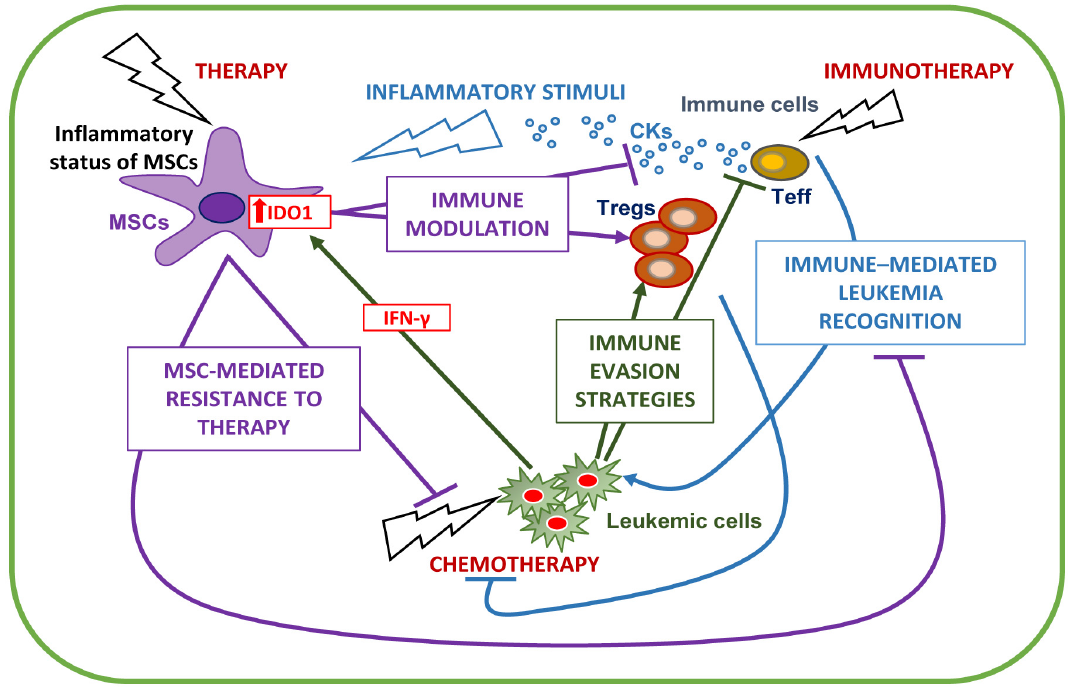
Figure 3. MSC, immune, and leukemic cell mutual interactions. Mesenchymal stromal cells (MSCs) mediate drug resistance through the mechanisms described in Figure 1 (purple). The therapy can influence MSC inflammatory status, modulating MSC immune suppression activity, which leads to suppression of T cell function and induction of Tregs (purple). Immune cell functions are also affected by leukemic cells, which favor an immune-suppressive environment to promote immune escape, through several cell-intrinsic (see Figure 2A,B) and cell-extrinsic mechanisms (i.e., EV release, aberrant metabolism, and the exploitation of other cells through CKs, e.g., IFN- γ which leads to IDO1 upregulation in MSCs) (green). A dysfunctional immune system can also influence the response to therapy (blue) (see Figure 2C). On the contrary, immunotherapy harnesses immune cells to recognize and destroy leukemic cells (blue). At the same time, the activation of the immune system is paralleled by an inflammatory status that could reprogram the MSC behavior, tuning immune suppression (purple). Tregs, T regulatory cells; T eff, T effector cells; EVs, extracellular vesicles; CKs, cytokines; IFN- γ , interferon- γ ; IDO1, indoleamine 2,3, dioxygenase 1.